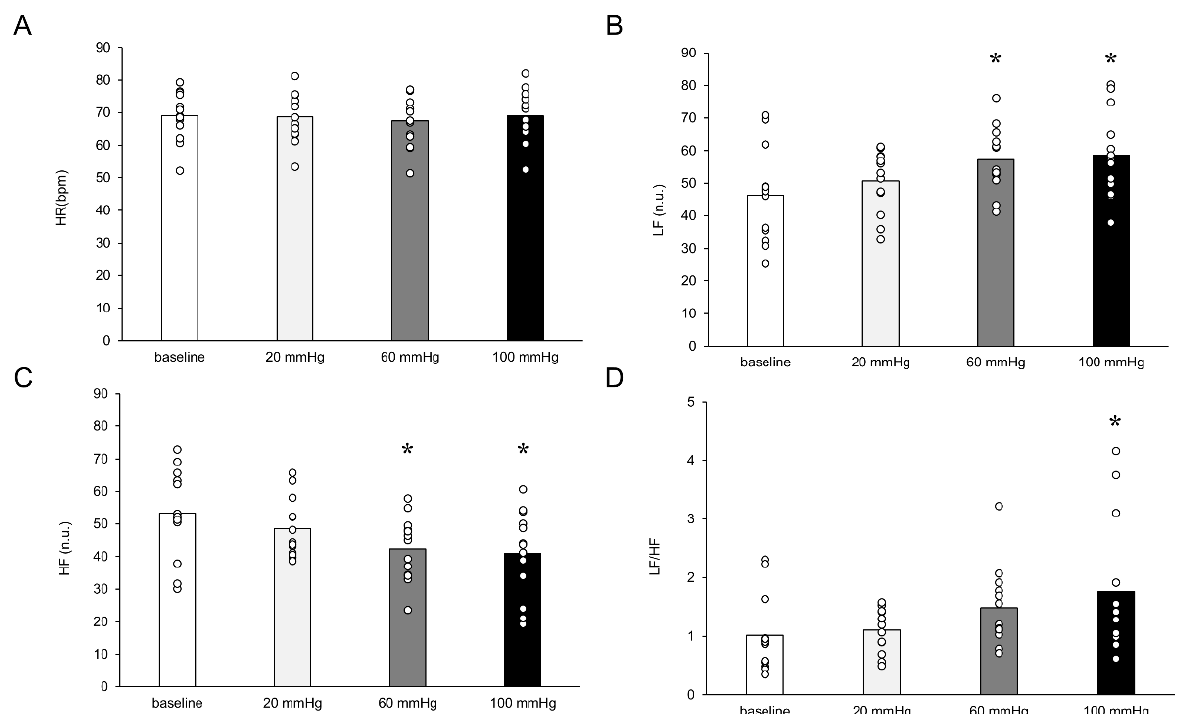
Figure 4. Effects of venous occlusion on heart rate variability. Shown are the ( A ) heart rate (HR), ( B ) low-frequency (LF), ( C ) high-frequency (HF) components of heart rate variability (HRV), and ( D ) the resultant effect on the LF/HF balance. White dots indicate the data for each participant. LF increased and HF decreased at occlusion pressures of 60 and 100 mmHg ( p < 0.05). The LF/HF balance increased at an occlusion pressure of 100 mmHg ( p < 0.05). * p < 0.05 compared to resting baseline.